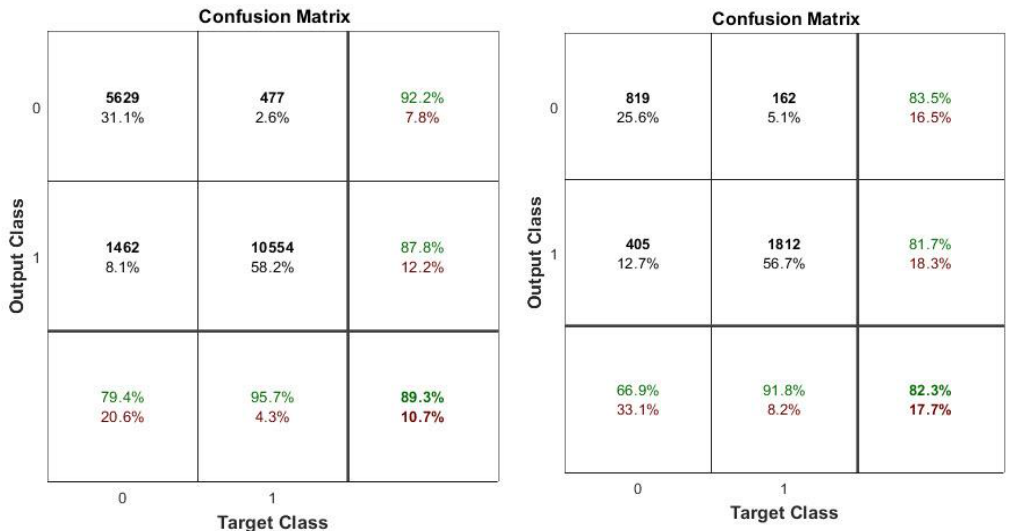
Figure 6 Performance accuracy of FFNN predictor based on confusion matrix.